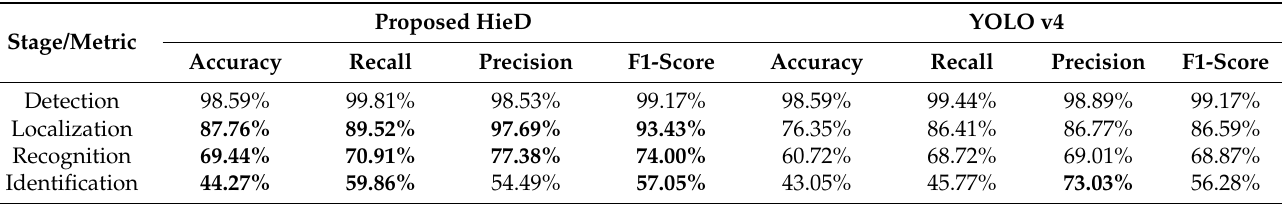
Table 12. The performance metrics of HieD and